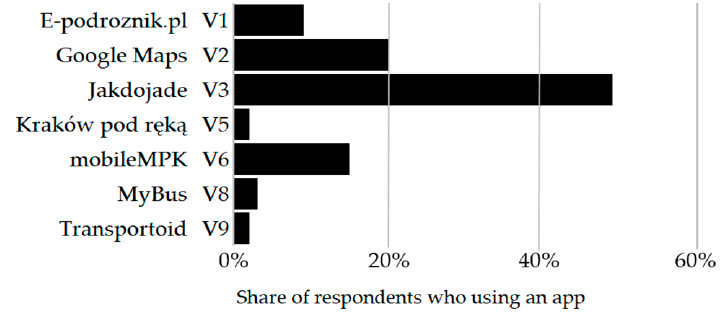
Figure 11. Share of apps used in travels within the Cracow agglomeration based on survey infor- mation.